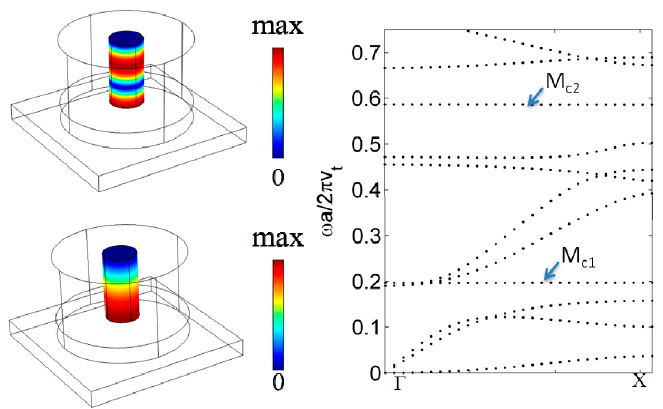
Figure 7. ( Left panel ): 3D-schematic view of the pressure fields in water of the M c1 ( left-lower ) and M c2 ( left-upper ) compressional modes; ( Right panel ): Dispersion curves of the PnC with geometric parameters h/a = 0.4, r/a = 0.39, r i /a = 0.1, h w /h = 1, l/a = 0.1 along the Γ X direction.